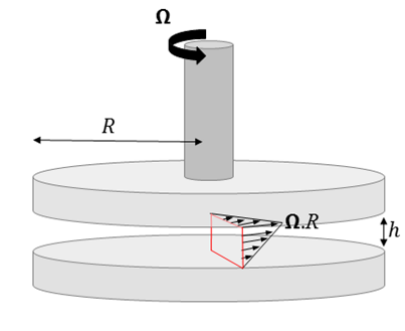
Figure 2. Parallel plate geometry.